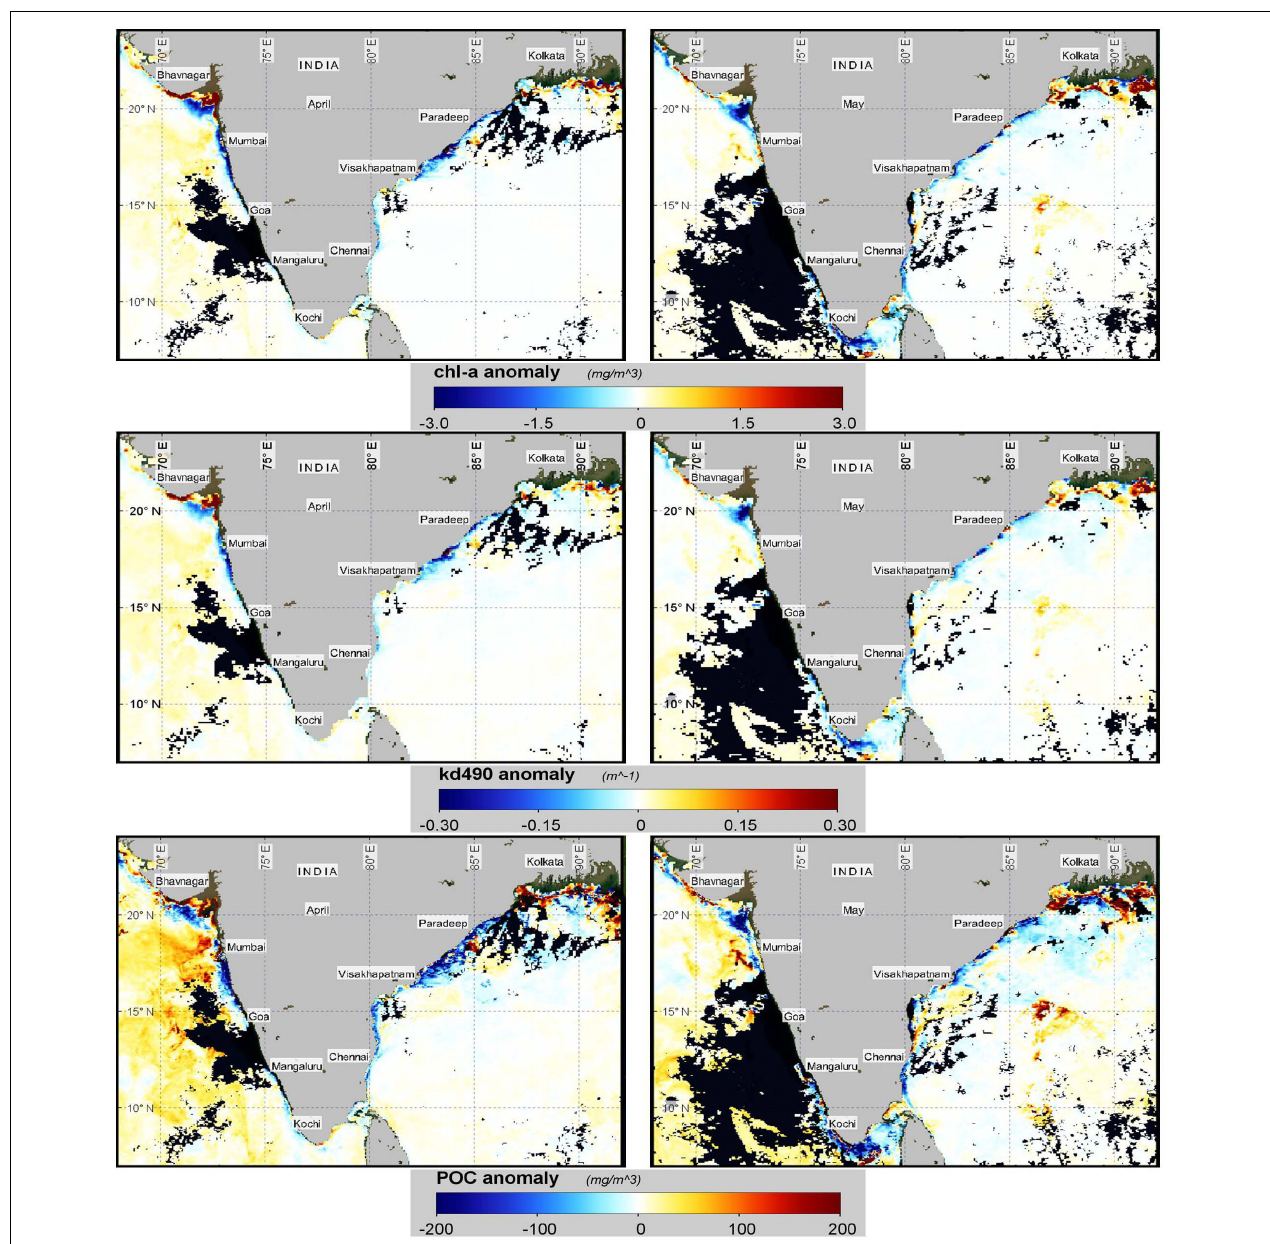
FIGURE 6 | Spatial distribution of chl- a , k d 490, and POC anomaly for April and May 2020 derived using MODISA